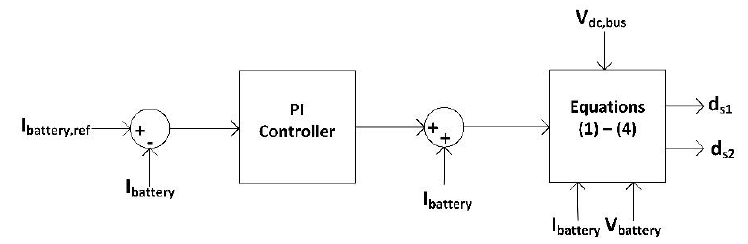
Figure 3. The control scheme of the bidirectional charger. Reprint with permission [29]; 2020, IEEE.